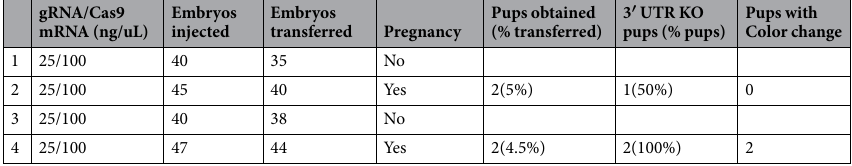
Table 1. Generation of Tyr 3 ′ UTR KO rabbits using CRISPR/Cas9.